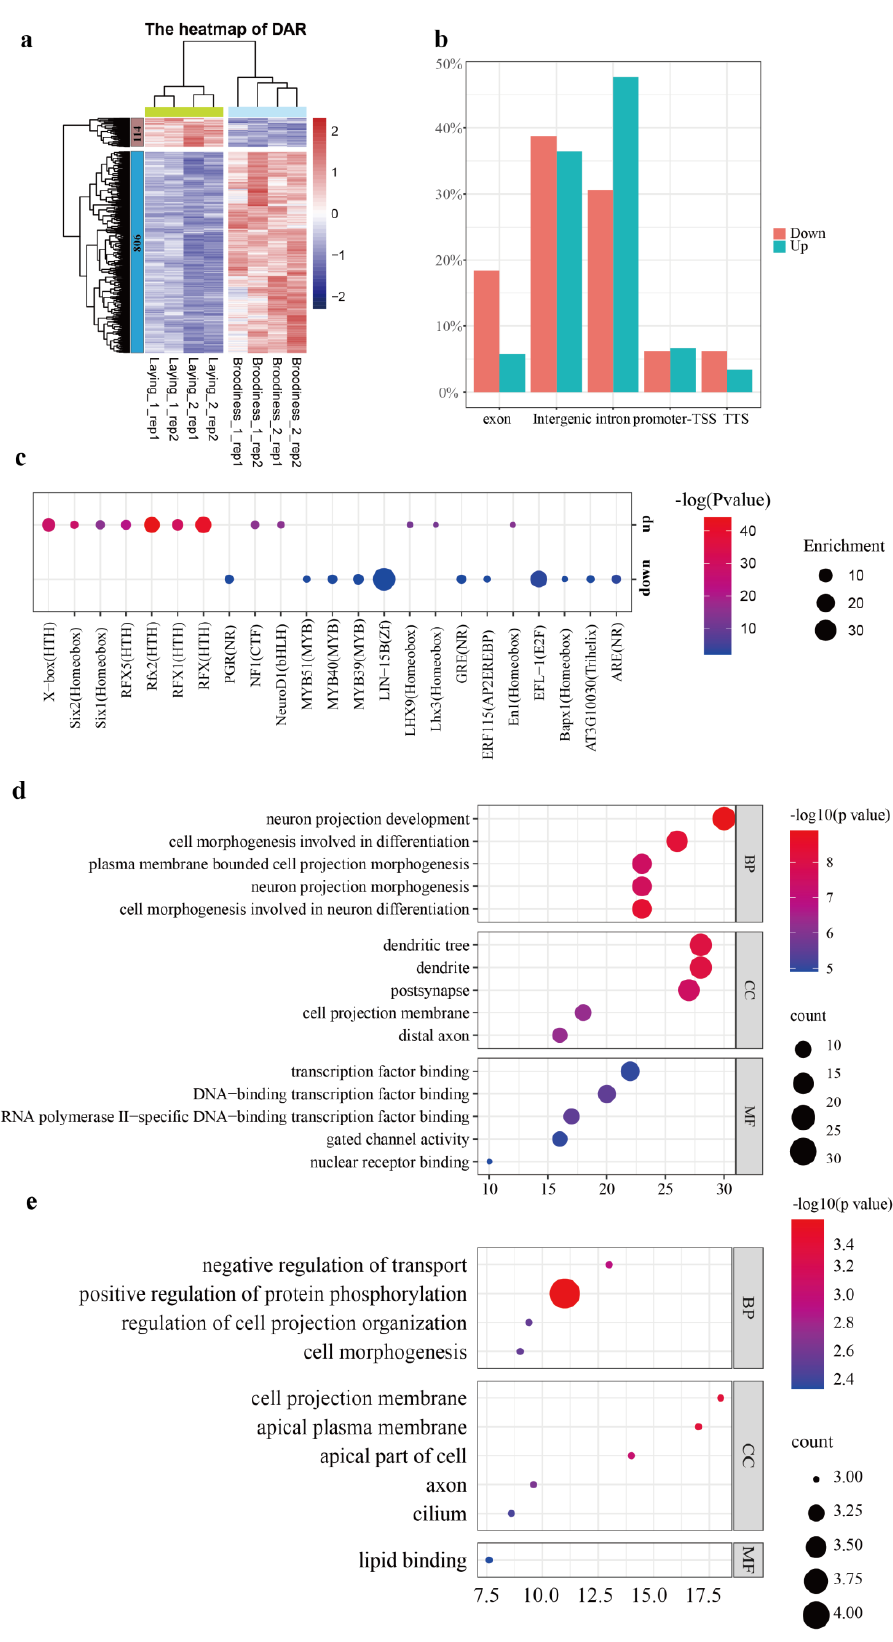
Figure 3. Calculation, distribution annotation, and GO function annotation of differential accessibility regions (DARs) in ATAC-seq data. ( a ) The heatmap of the 920 DARs between pairwise